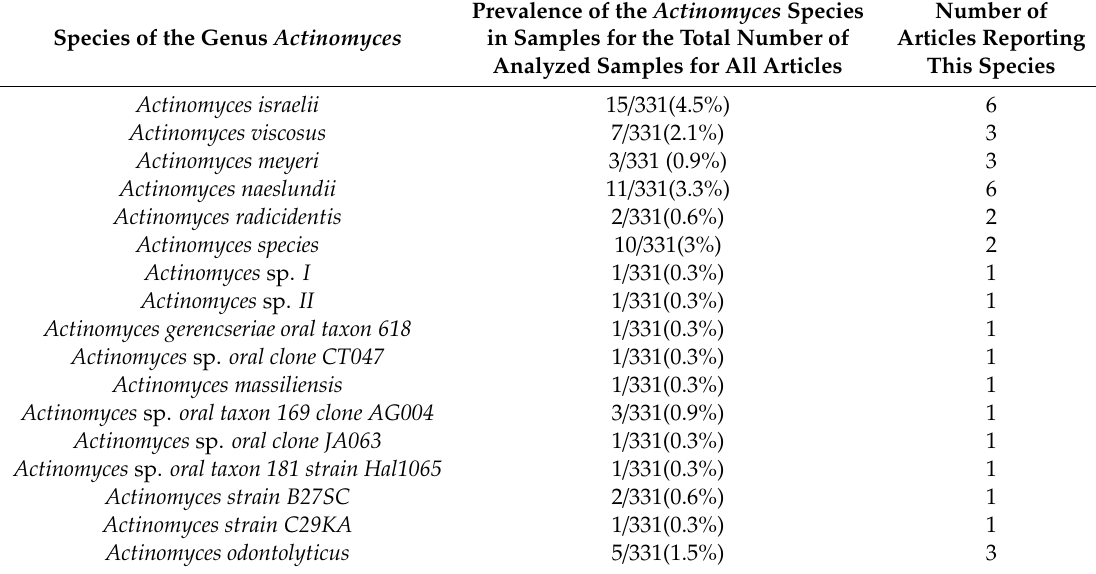
Table 6. Prevalence of the individual Actinomyces species, given the total number of samples for all articles selected for this review. We have the greatest number of positive samples with Actinomyces israelii and Actinomyces naeslundii